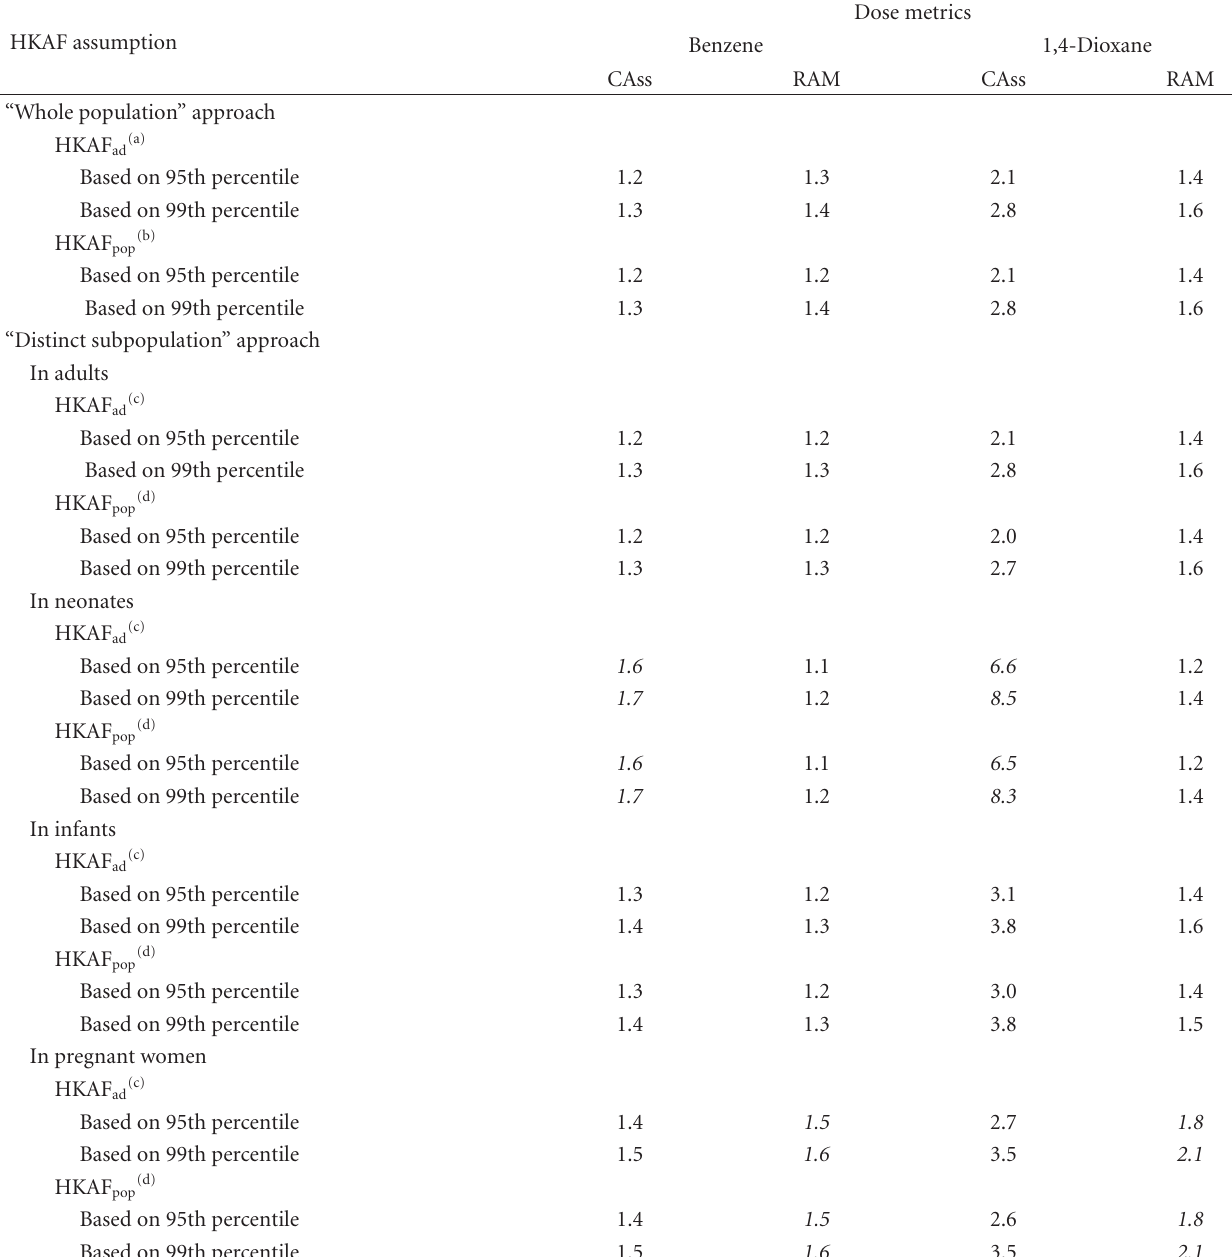
Table 5: HKAFs obtained by the “distinct subpopulation” approach on the basis of 100,000 Monte Carlo iterations in adults, neonates, infants, and pregnant women and by the “whole population” approach for the Canadian population. HKAF assumption